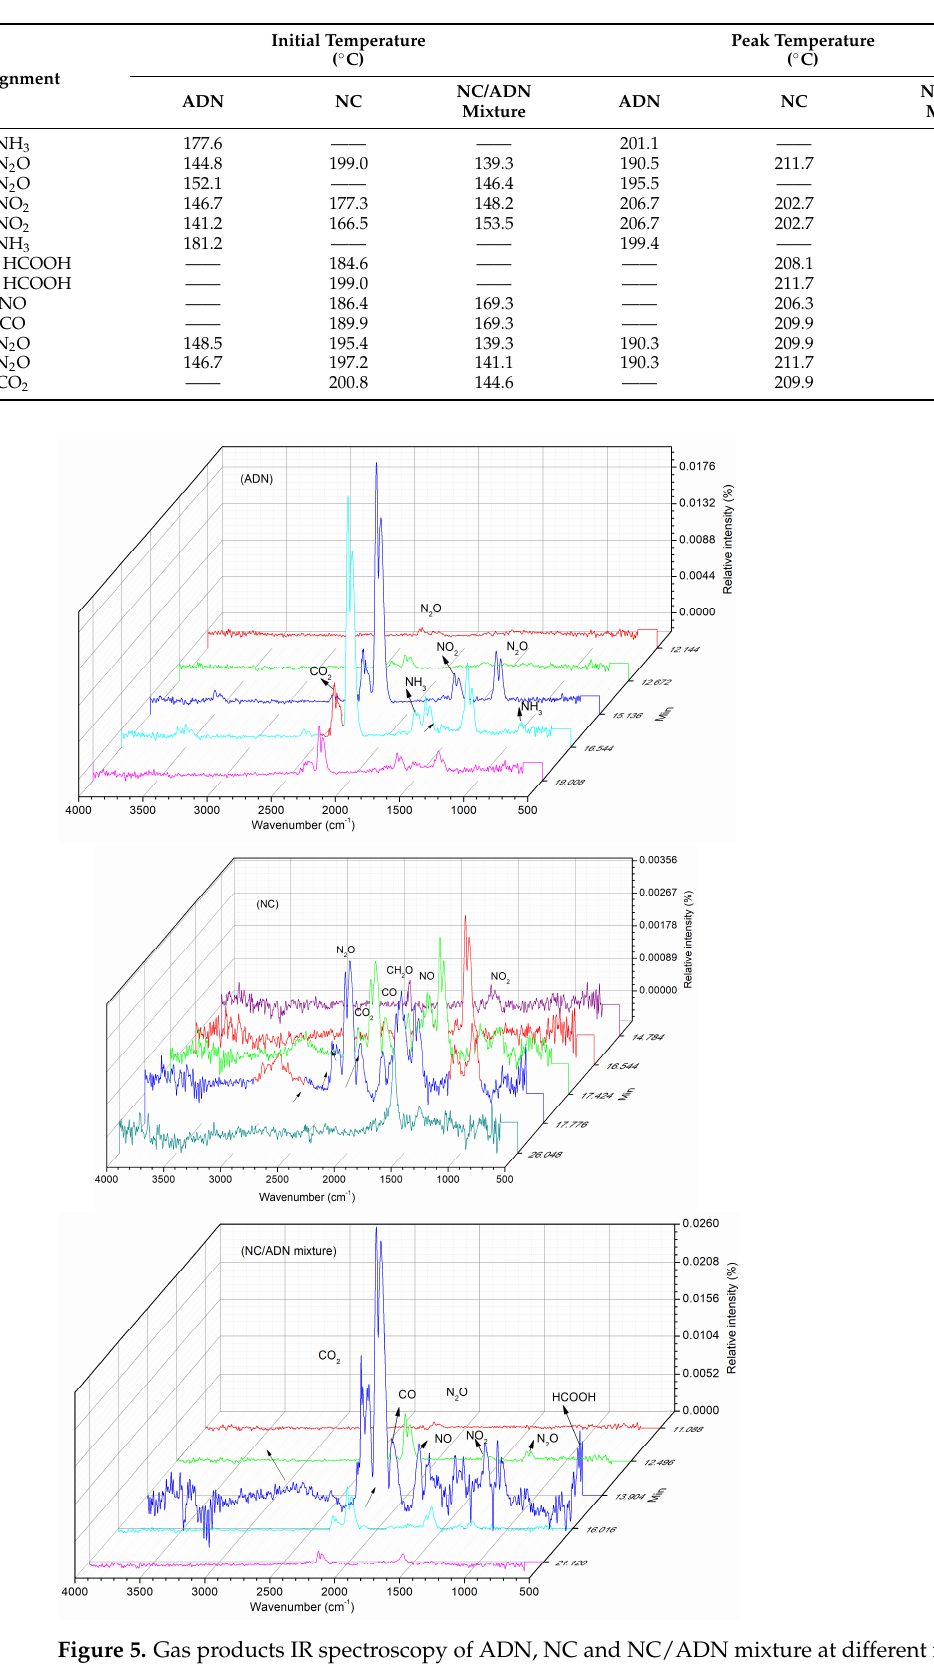
Table 7. Gas products and assignments of the thermal decomposition products of ADN.